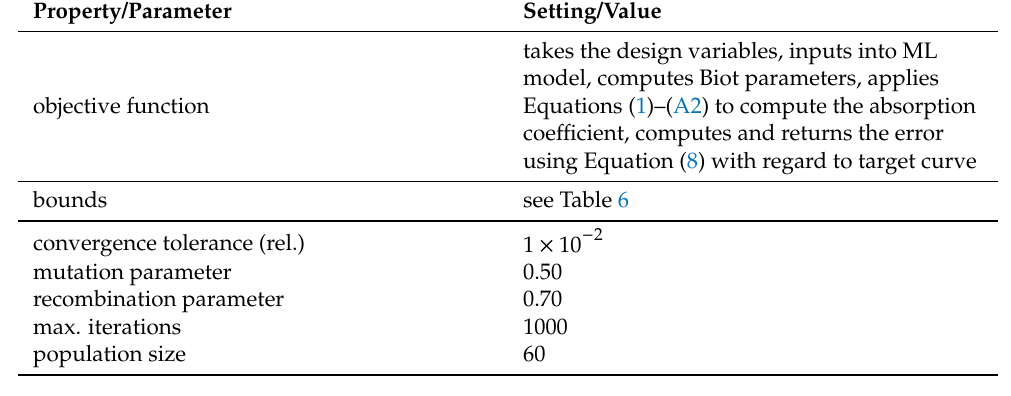
Table A5. Settings of the evolutional algorithm used for the inverse specimen design procedure. The implementation of the algorithm is used from the python library scipy [67] an follows [66]. Property/Parameter Setting/Value takes the design variables, inputs into ML model, computes Biot parameters, applies Equations (1)–(A2) to compute the absorption